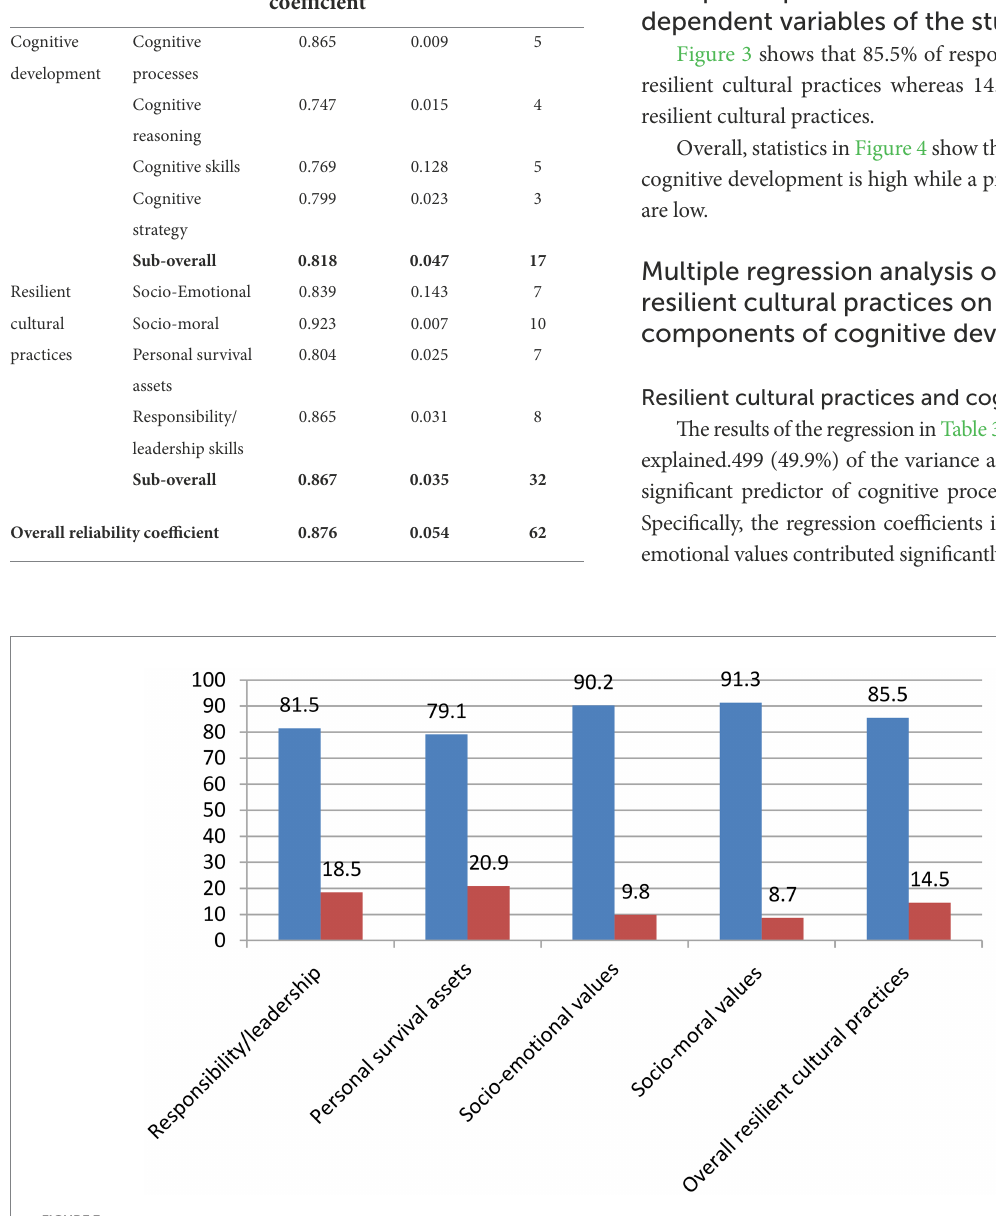
FIGURE 3 Respondents’ appraisal of resilient cultural